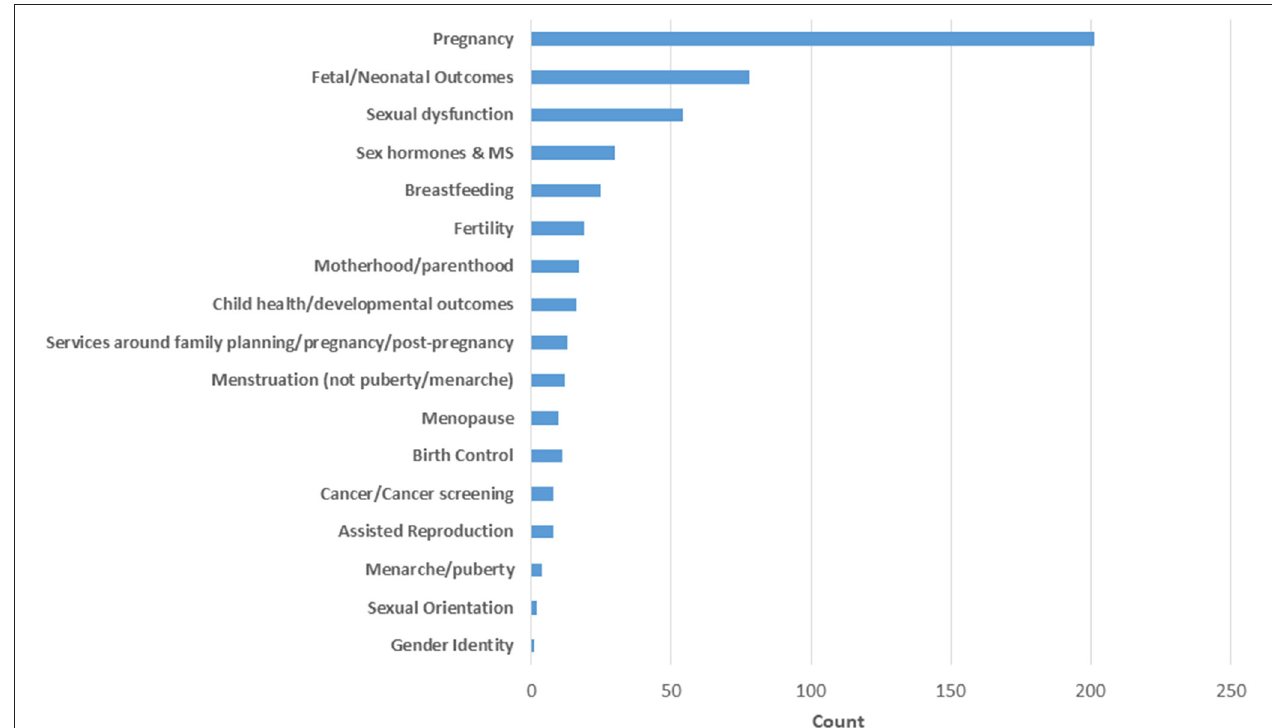
FIGURE 6 | Frequency of topics